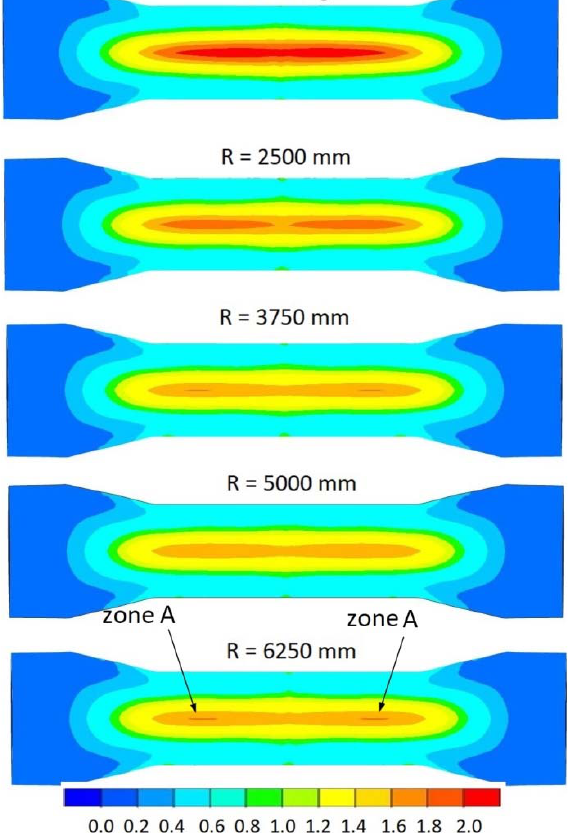
Figure 16. Distribution of the normalised Cockcroft–Latham damage criterion.